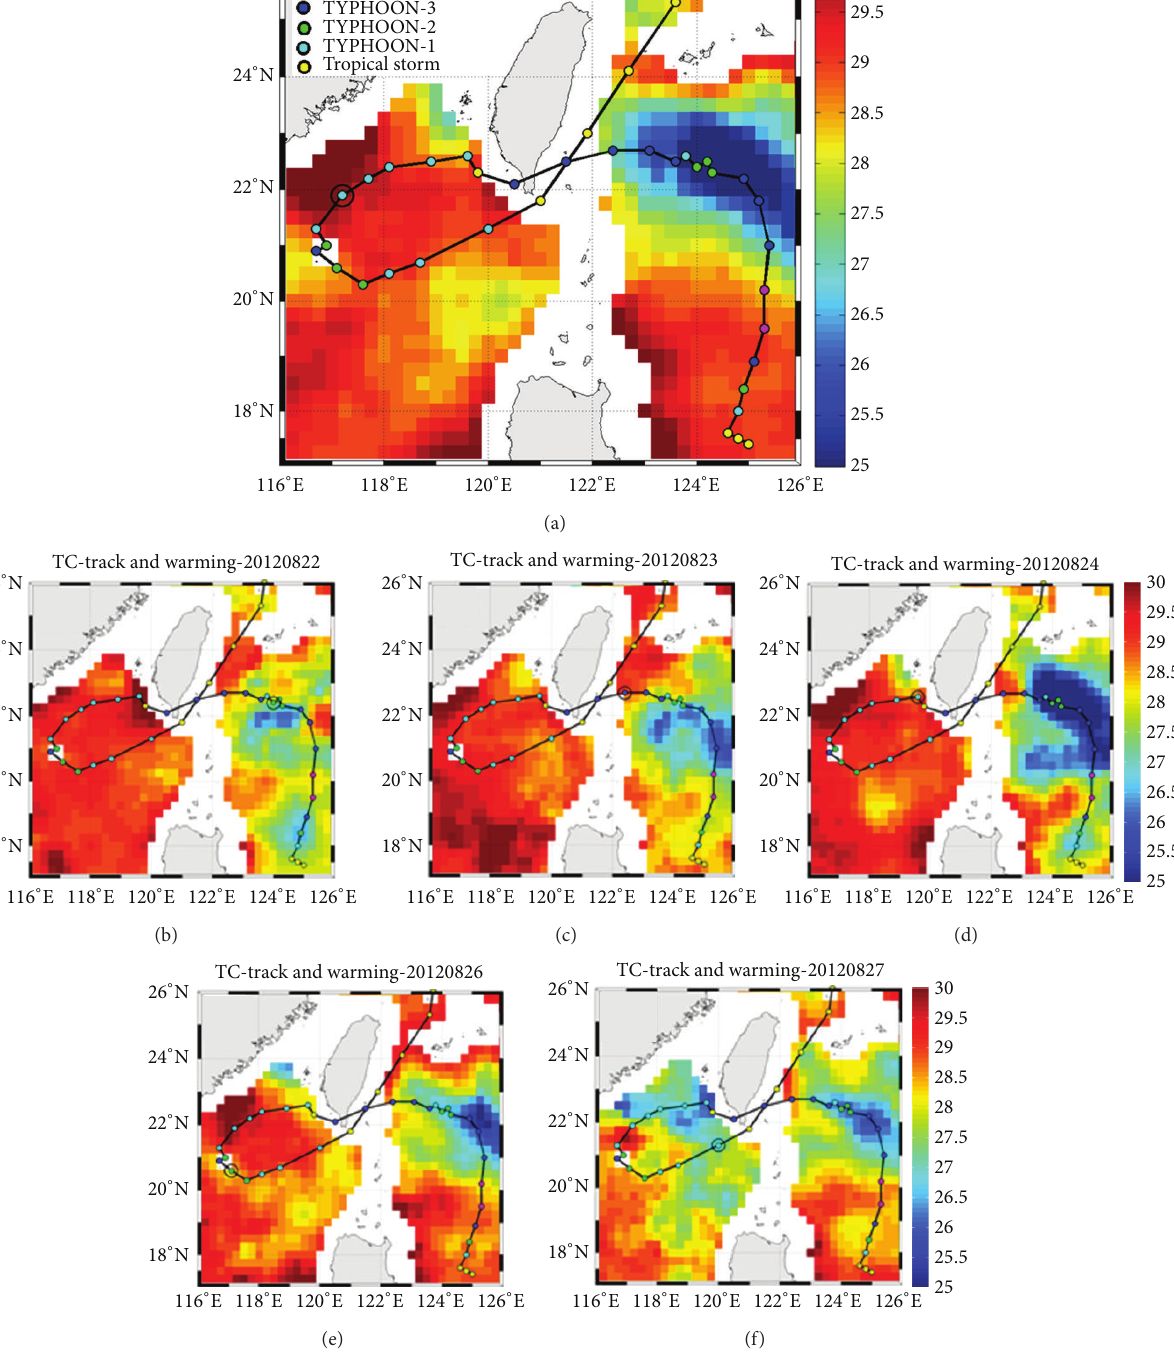
Figure 1: SST (unit: degree C) evolution during the generation of unusual warming patch located at the coastal region of NSCS on August 25, 2012 (a) and 22 August (b) before the rapid intensification of Tembin. Colored dots denoted the moving track and corresponding TC intensity (in Saffir-Simpson hurricane wind scale) of